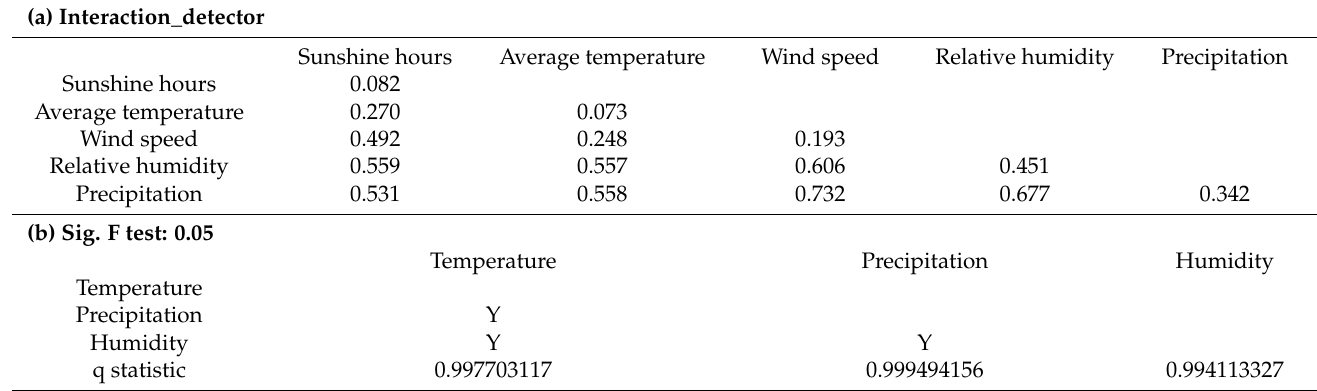
Table 6. (a). Results of cross-detection. (b). Ecological detection and risk factor